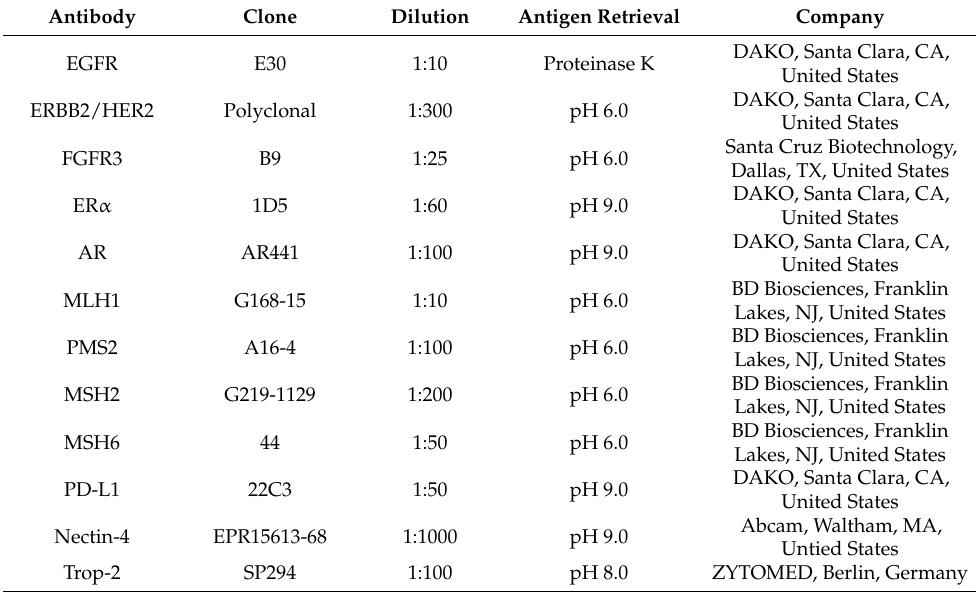
Table 8. Details for immunohistochemical antibodies